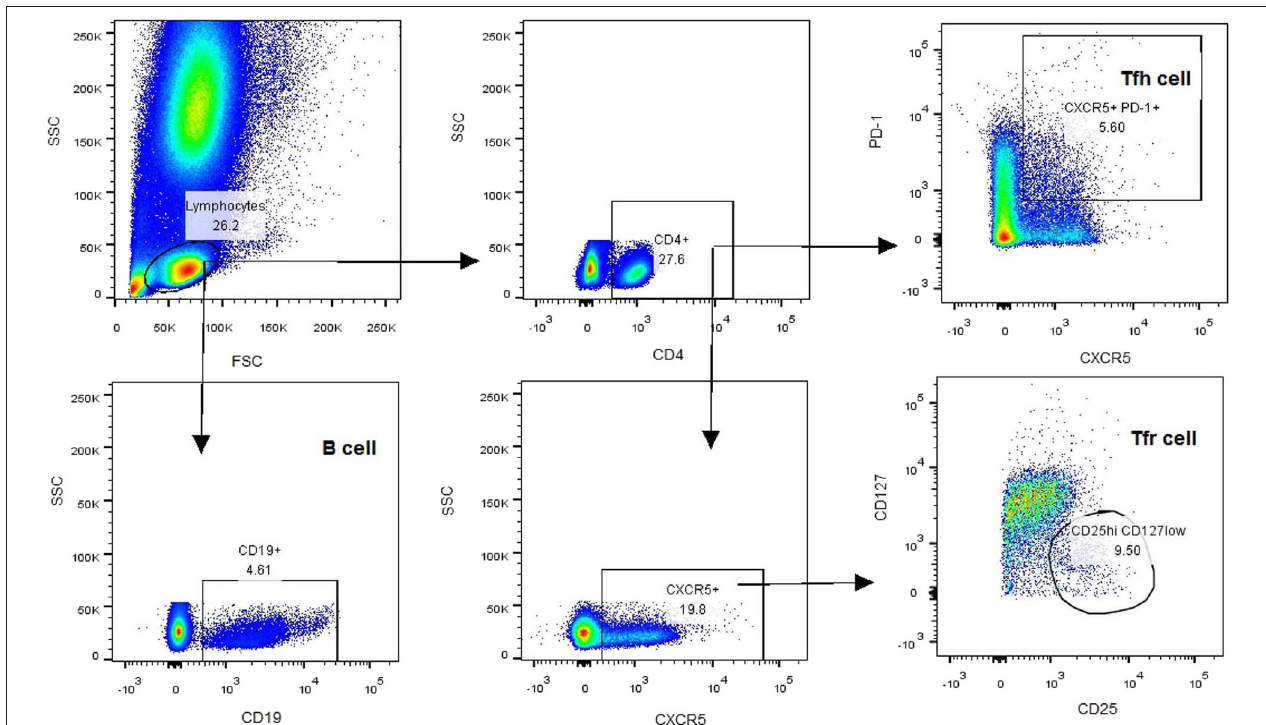
FIGURE 1 | Flow cytometry sorting of cTfh, cTfr, and CD19 + B